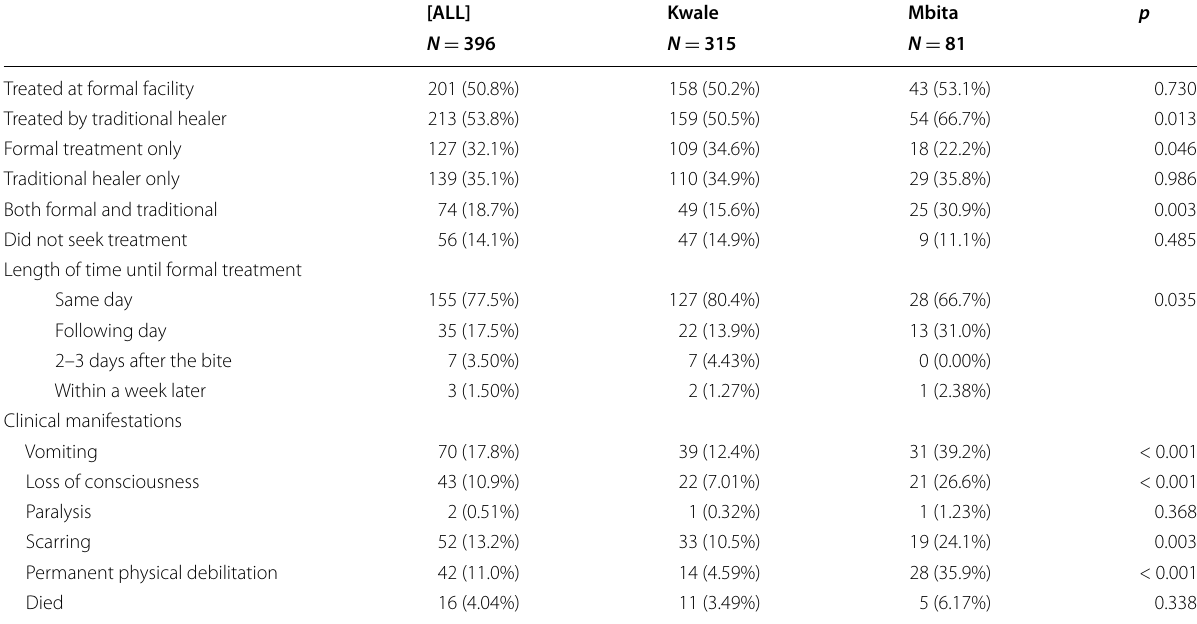
p -values are from Chi-square tests for Independence between region and categorical